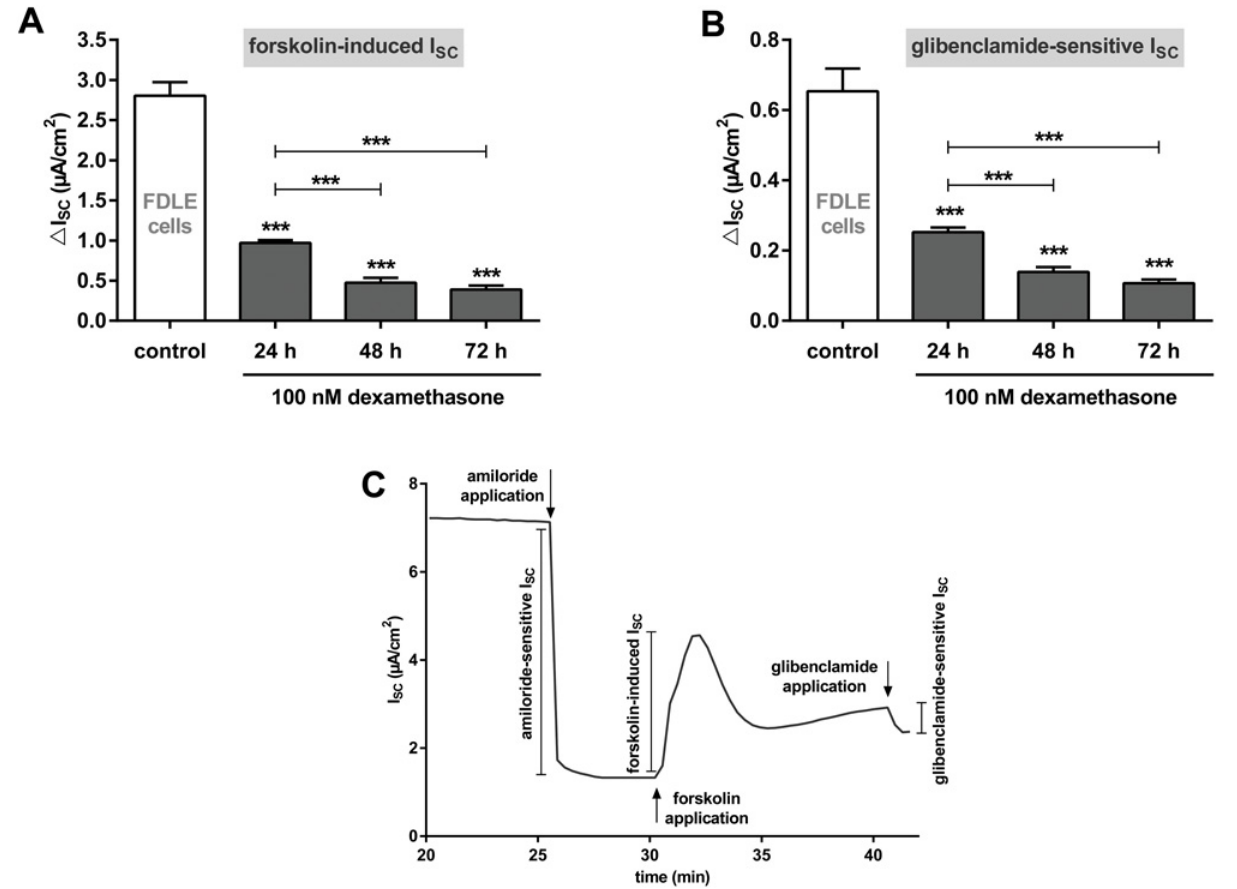
Fig 2. Dexamethasone reduces Cftr channel activity in FDLE cells. Graphs represent the mean + SEM of I SC in response to 100 nM dexamethasone for 24, 48 and 72 h measured in Ussing chambers. A: Forskolin-induced I SC (n = 25 – 56, *** p < 0.001, ANOVA with Tukey's post hoc test). B: Glibenclamide- sensitive I SC (n = 25 – 55, *** p < 0.001, ANOVA with Tukey's post hoc test). C: Typical current tracing of FDLE monolayers.